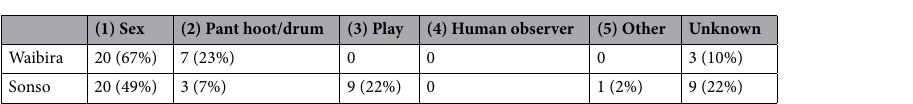
Figure 1. Number of observations of each leaf-modifying gesture form in each community by age/sex category. Intermediate forms (i.e., cases in which multiple forms are used within the same event) are presented in-between columns of two forms. (e.g., leaf-pull/leaf-tear). Illustrations show what the leaves look like after they have been modified. Moving from the bottom to the top these different forms become more audible. Pie chart colours represent the proportion of cases observed in each behavioural context (Sex, Pant-hoot/drumming, Play, or Unknown).